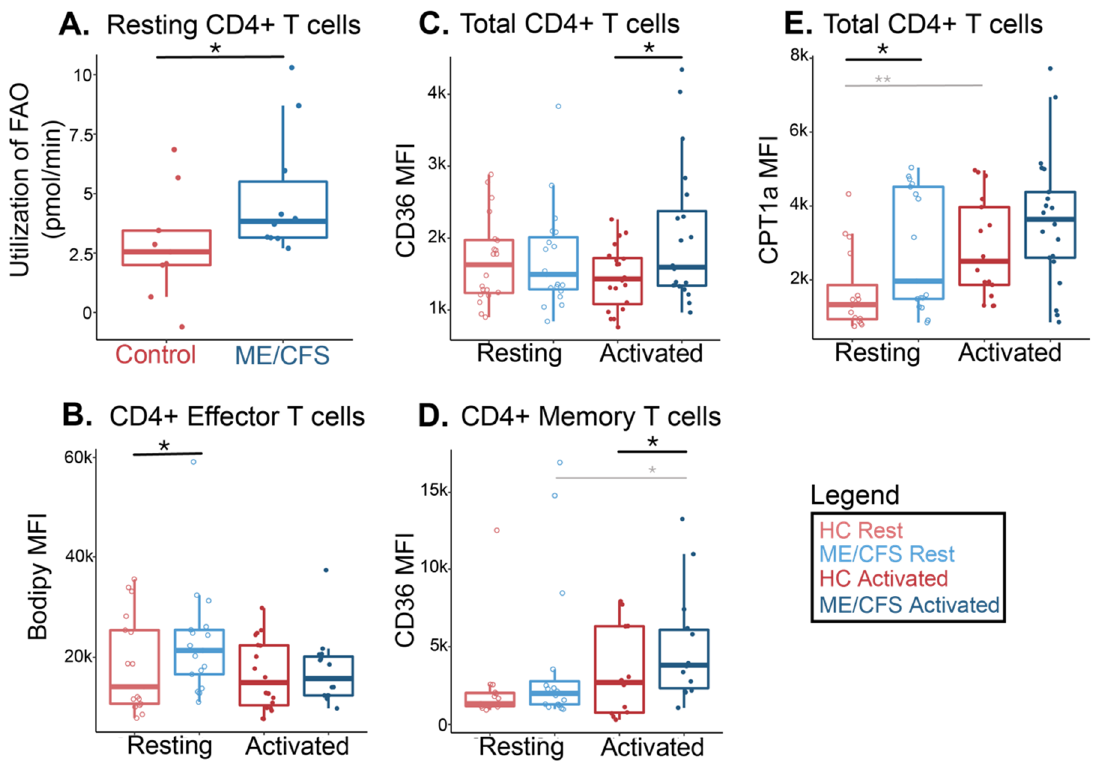
Figure 5. ME/CFS CD4+ T cells increased fatty acid oxidation compared to healthy controls. ( A ) Fatty acid oxidation measurements from a Seahorse extracellular flux analysis of circulating CD4+ T cells ( n = 9 healthy control samples; n = 10 ME/CFS samples). Each dot represents the change in oxygen consumption rate (pmol/min) under high energy demands following the injection of etomoxir in one sample, with an average of 2–3 technical replicates. ( B ) Median fluorescence intensity of a supplied fatty acid (Bodipy) in circulating and activated CD4+ effector T cells (CD27-CD28-CD45RA+/-) ( n = 16 healthy control samples at rest; n = 17 ME/CFS samples at rest; n = 19 healthy control samples after activation; n = 15 ME/CFS samples after activation, [ n = 16/17/19/15]). ( C ) Median fluorescence intensity of a fatty acid cell membrane transporter, CD36, in total resting and activated CD4+ T cells ( n = 19/19/19/20). ( D ) Median fluorescence intensity of a fatty acid cell membrane transporter, CD36, in resting and activated CD4+ memory T cells (CD27+CD28+CD45RA − ) ( n = 14/16/12/14). ( E ) Mean fluorescence intensity of a fatty acid mitochondrial transporter, CPT1a, in total resting and activated CD4+ T cells ( n = 15/17/16/21). Box plots represent the median ± 25th and 75th quartiles. Whiskers represent 1.5× the interquartile ranges. Outliers are values outside the whisker range. Healthy control and ME/CFS data points are light (resting) or dark (activated) red or blue, respectively. For Seahorse data, * p < 0.05 by Wilcoxon rank-sum test. For flow cytometry data, * p < 0.05 and ** p < 0.01 by Kruskal–Wallis followed by Dunn’s test with FDR-based multiple testing correction. Gray lines and */** indicate a significant difference between ME/CFS and ME/CFS or healthy control and healthy control cohorts before and after stimulation.